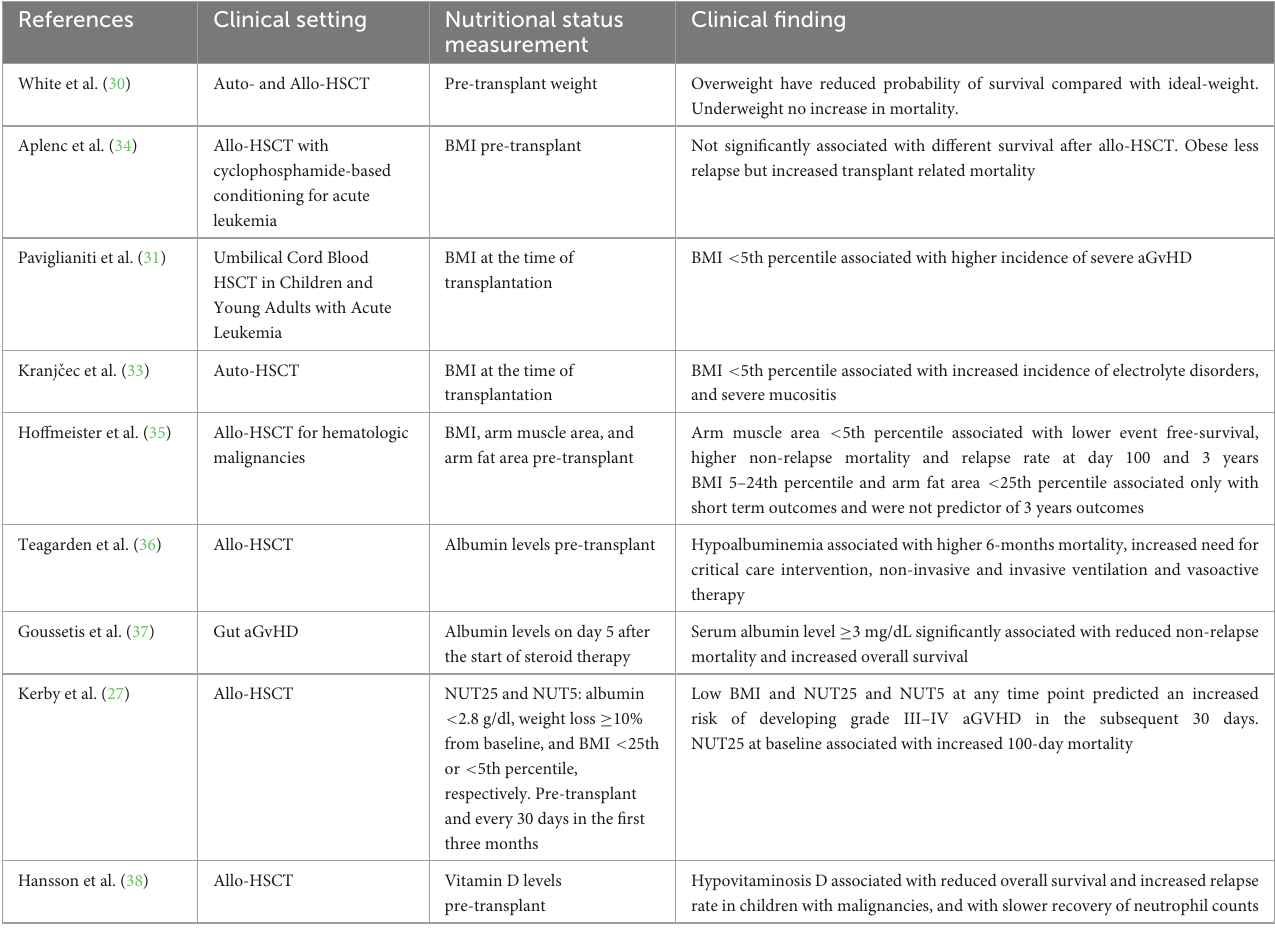
TABLE 1 Main studies on the relationship between nutritional status and clinical outcomes in